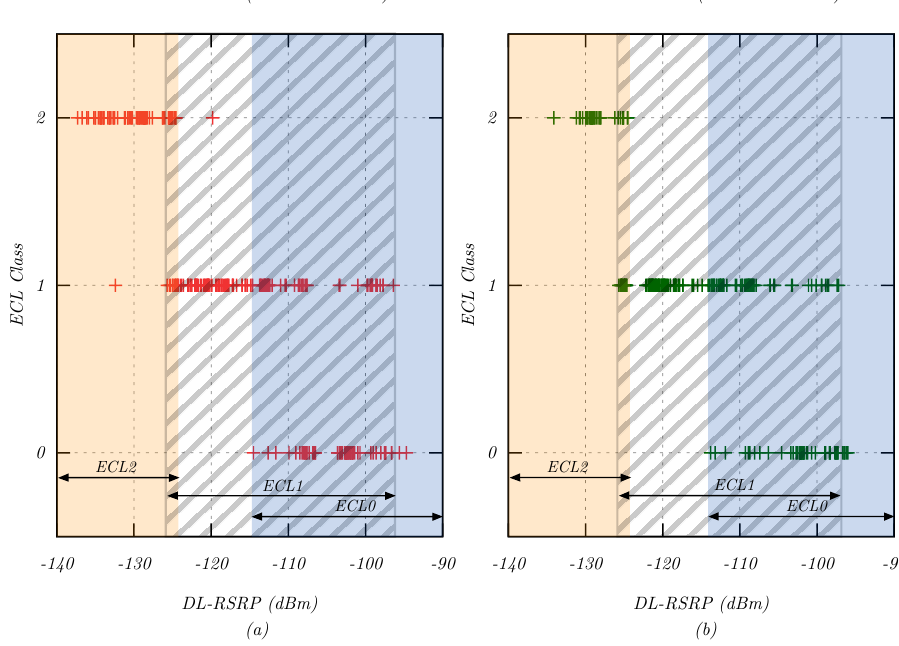
Figure 7. Relationship between ECL selected by the modem and downlink RSRP signal level during ( a ) uplink and ( b ) downlink transmissions.